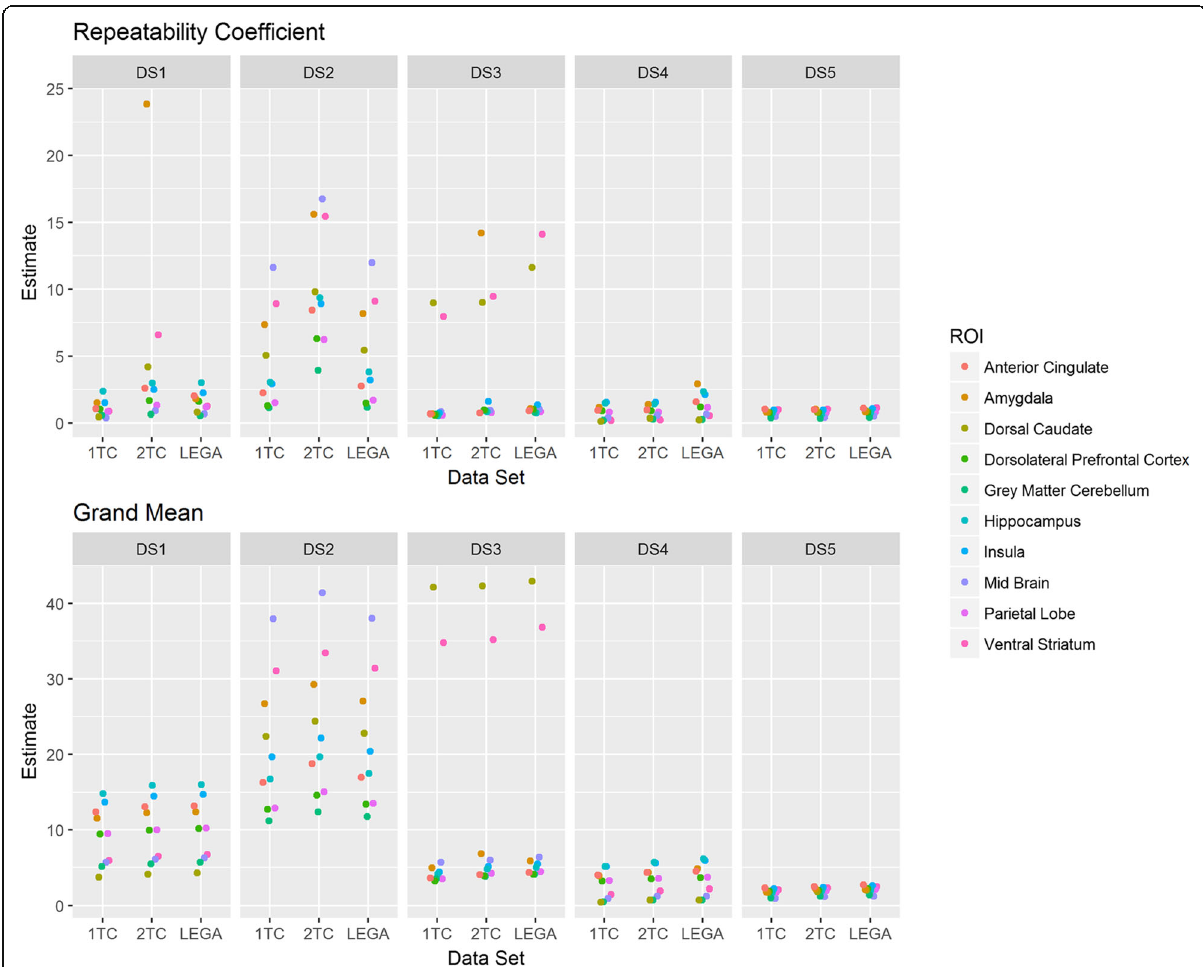
Fig. 3 Repeatability coefficient (RC) and grand mean across the considered datasets (upper panel and lower panel respectively). Each point in the plot, for a given dataset, represents a particular region of interest (ROI) so that the plot represents the variability of RC across the considered ROIs. For each data set, DS1, DS2, DS3, DS4, and DS5, there were three quantification methods investigated (1, 2, and L denote one-tissue compartment model, two-tissue compartment model, and likelihood estimation in graphical analysis,